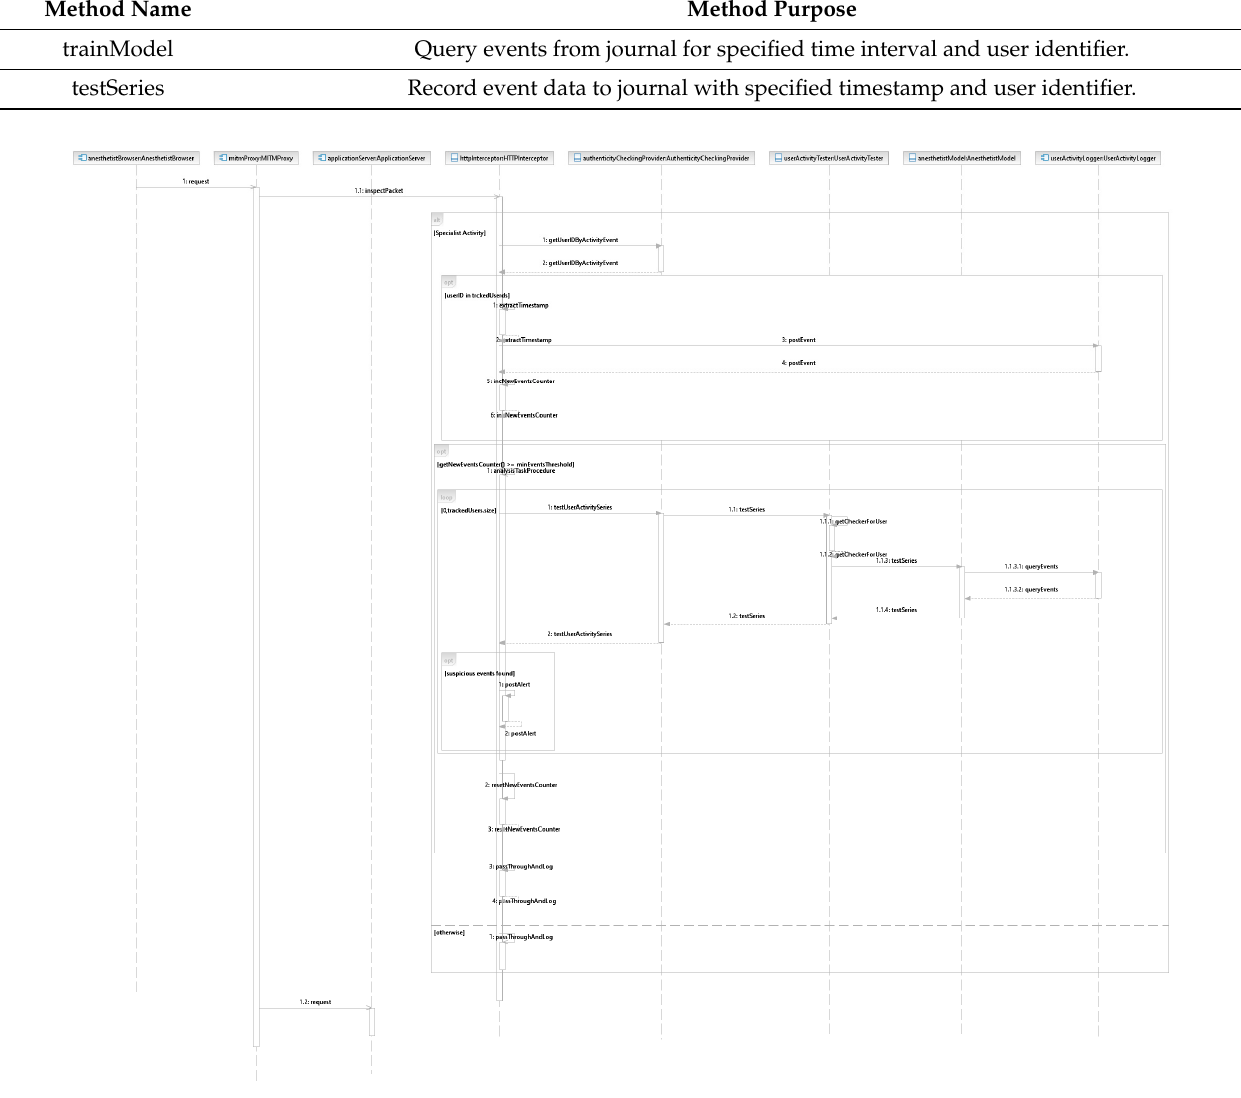
Figure A2. Analysis of user activity (sequence